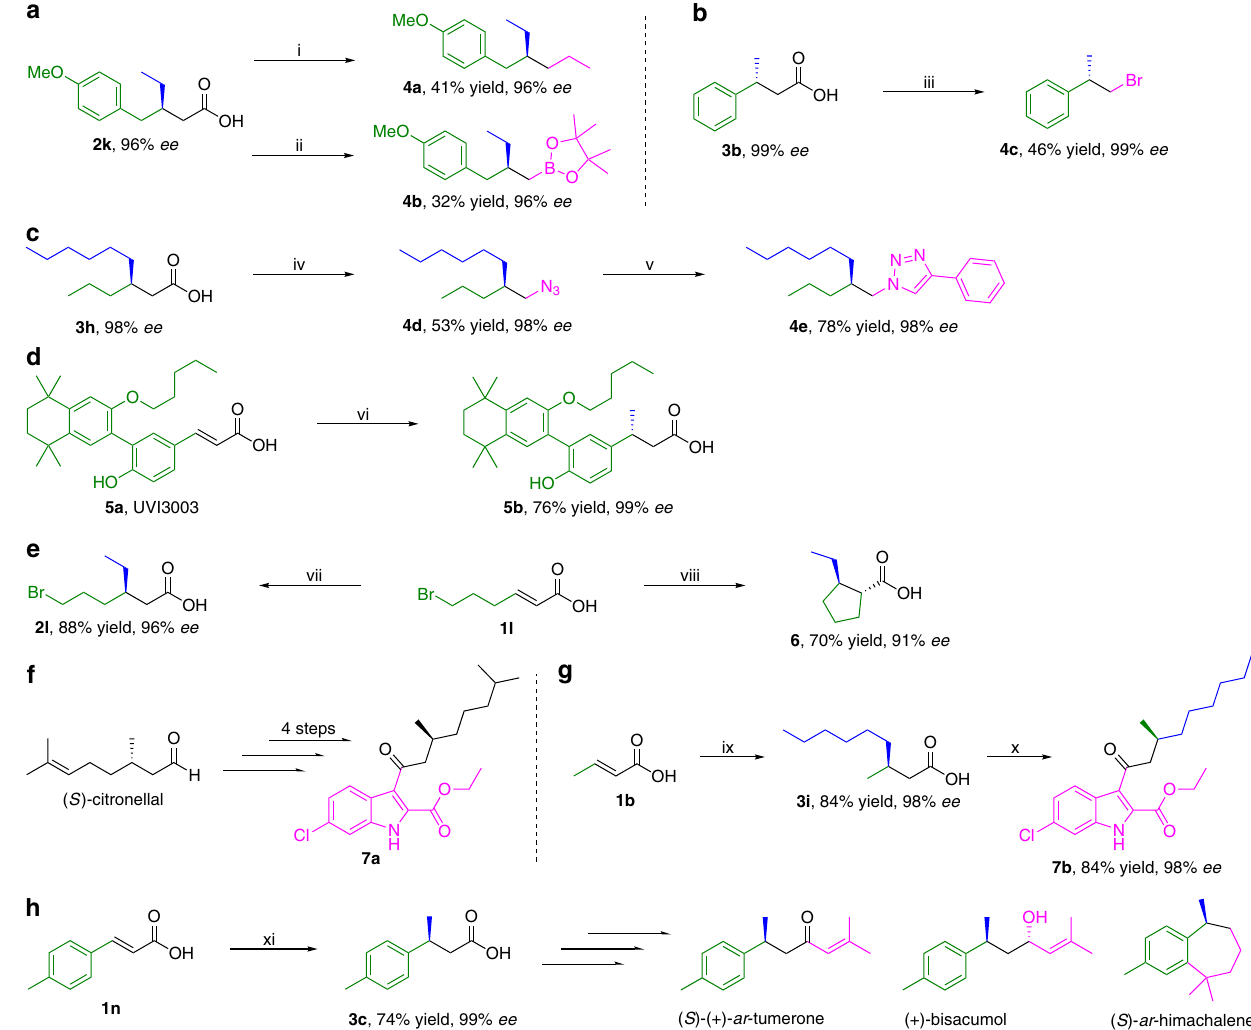
Fig. 5 Synthetic utility of the process. a Ni-catalyzed decarboxylative alkylation and borylation of chiral acid 2k . b Ag-catalyzed decarboxylative bromination of product 3b . c Ag-catalyzed decarboxylative azidation of chiral acid 3h followed by click reaction. d Late-stage functionalization of a RXR antagonist 5a